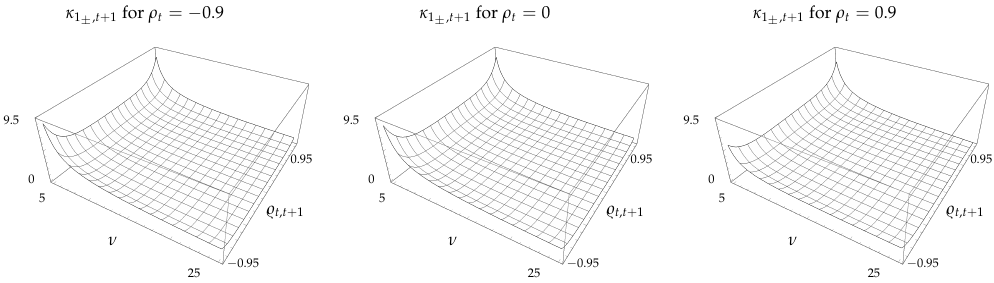
Figure 4. Excess kurtosis, κ 1